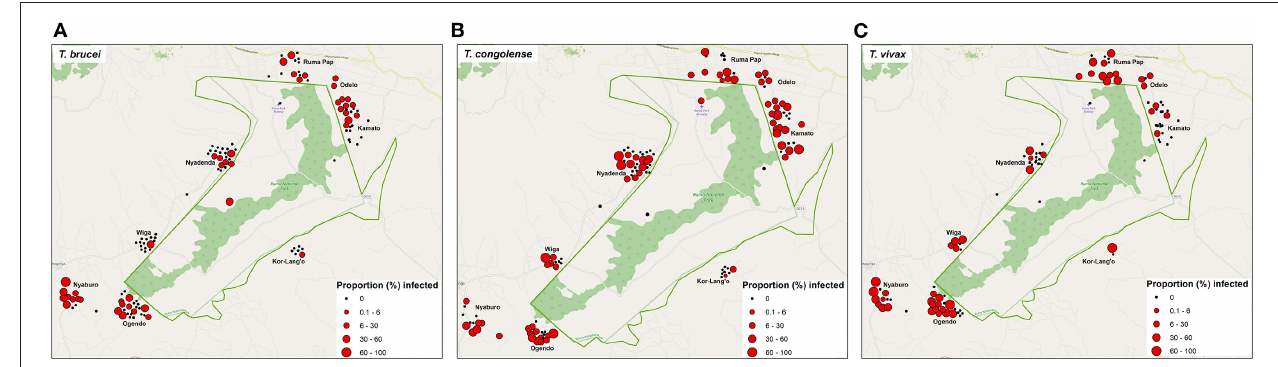
FIGURE 4 | Distribution map showing the pathogenic trypanosome species detected and overlay with the proportion of infected cattle in each homestead (A–C) as tested by PCR method.